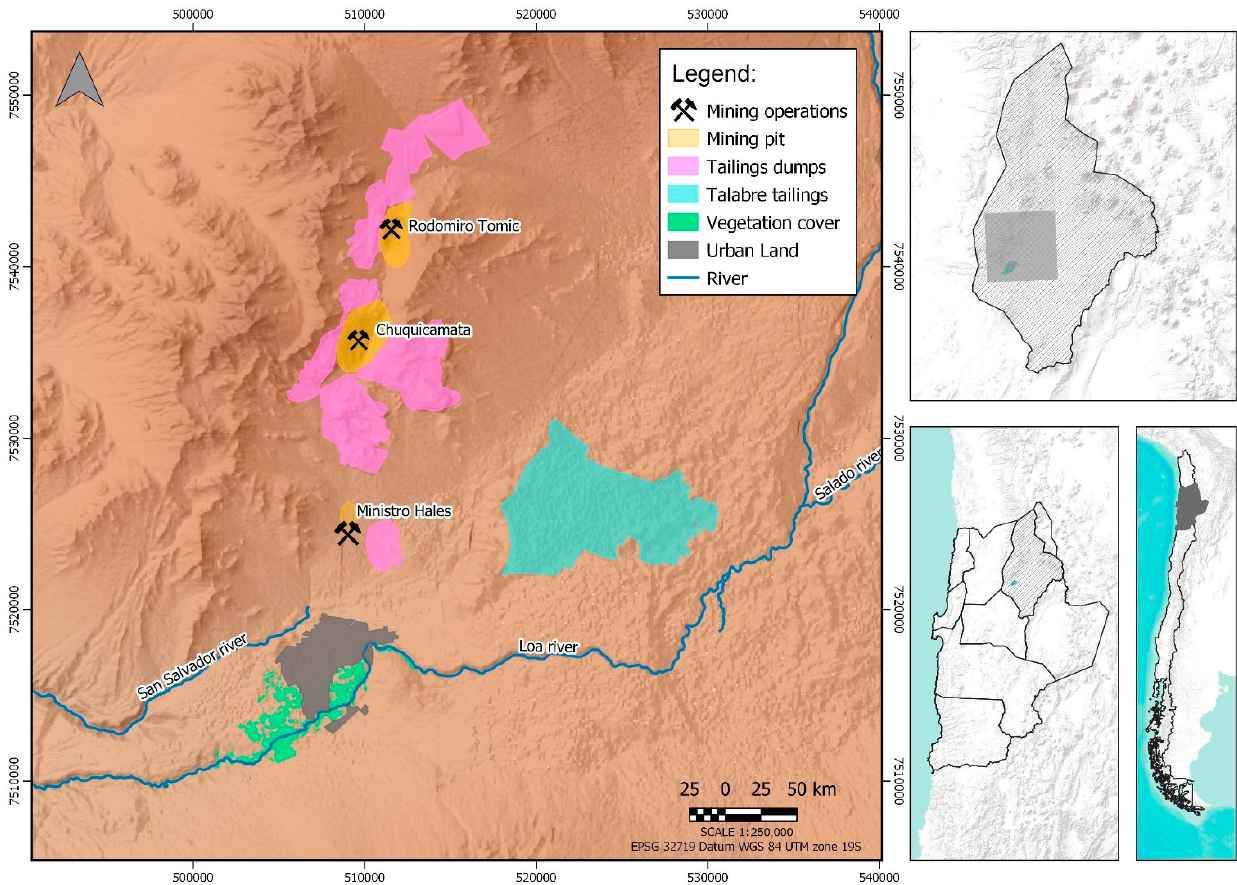
Figure 1. Location of the Calama oasis, Calama commune, Antofagasta Region, Chile, with the closest mining operations.